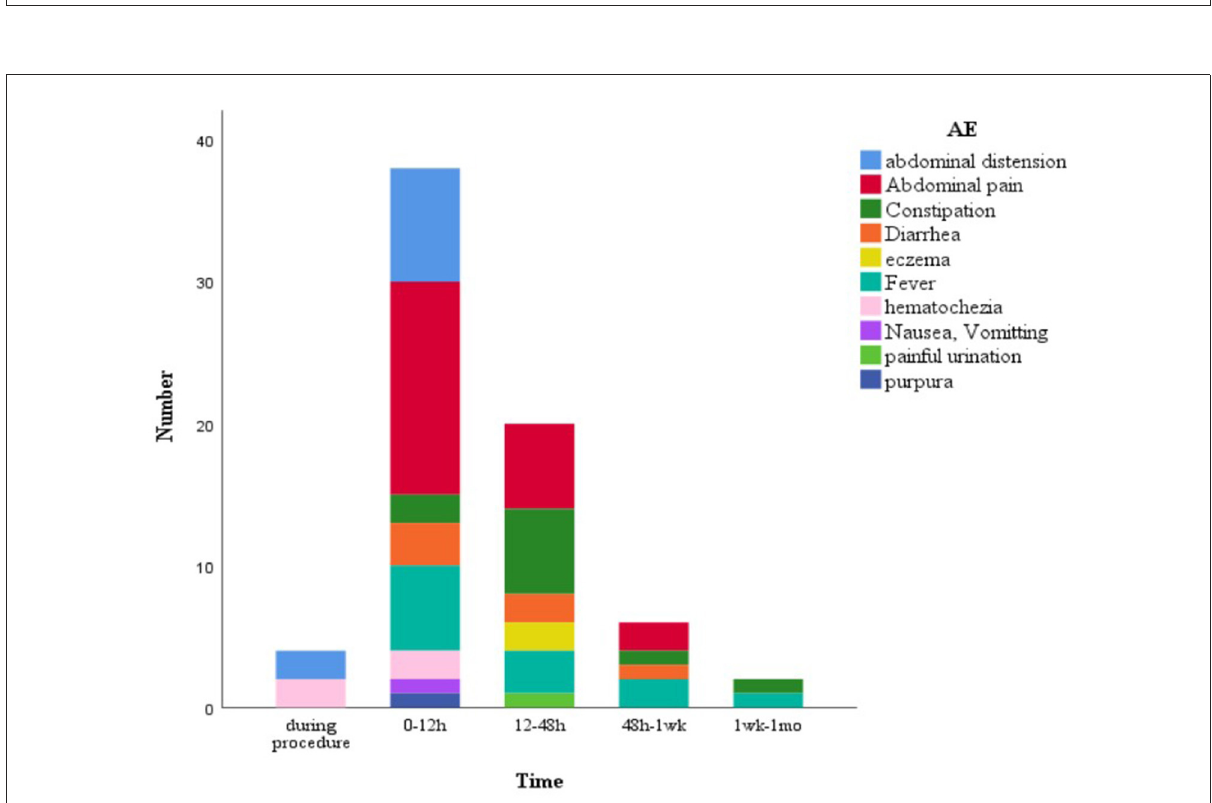
FIGURE3 FMT-related short-term AEs at diferent time points. 62 AEs (88.5%) appeared within 48h post-FMT. FMT, fecal microbiota transplantation; AEs, adverse